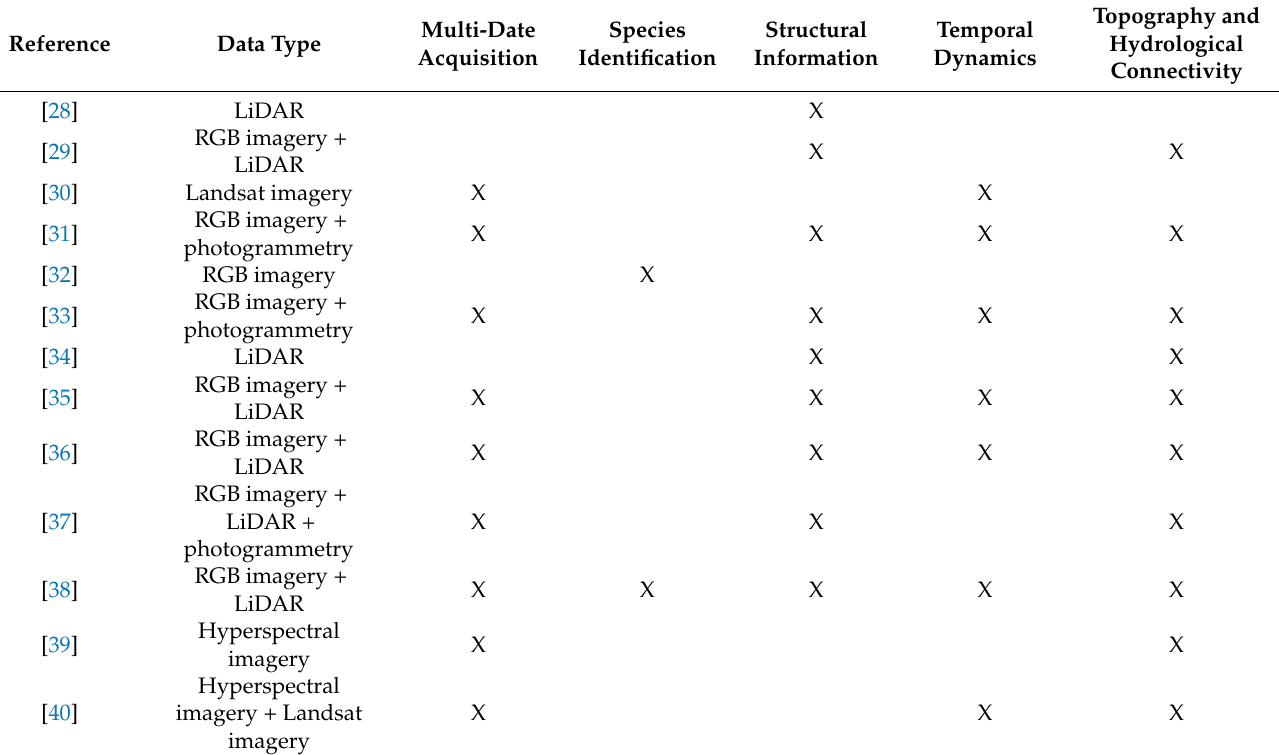
Table 1. Example remote sensing publications involving riparian forest with poplars and/or willows and the main focus of the